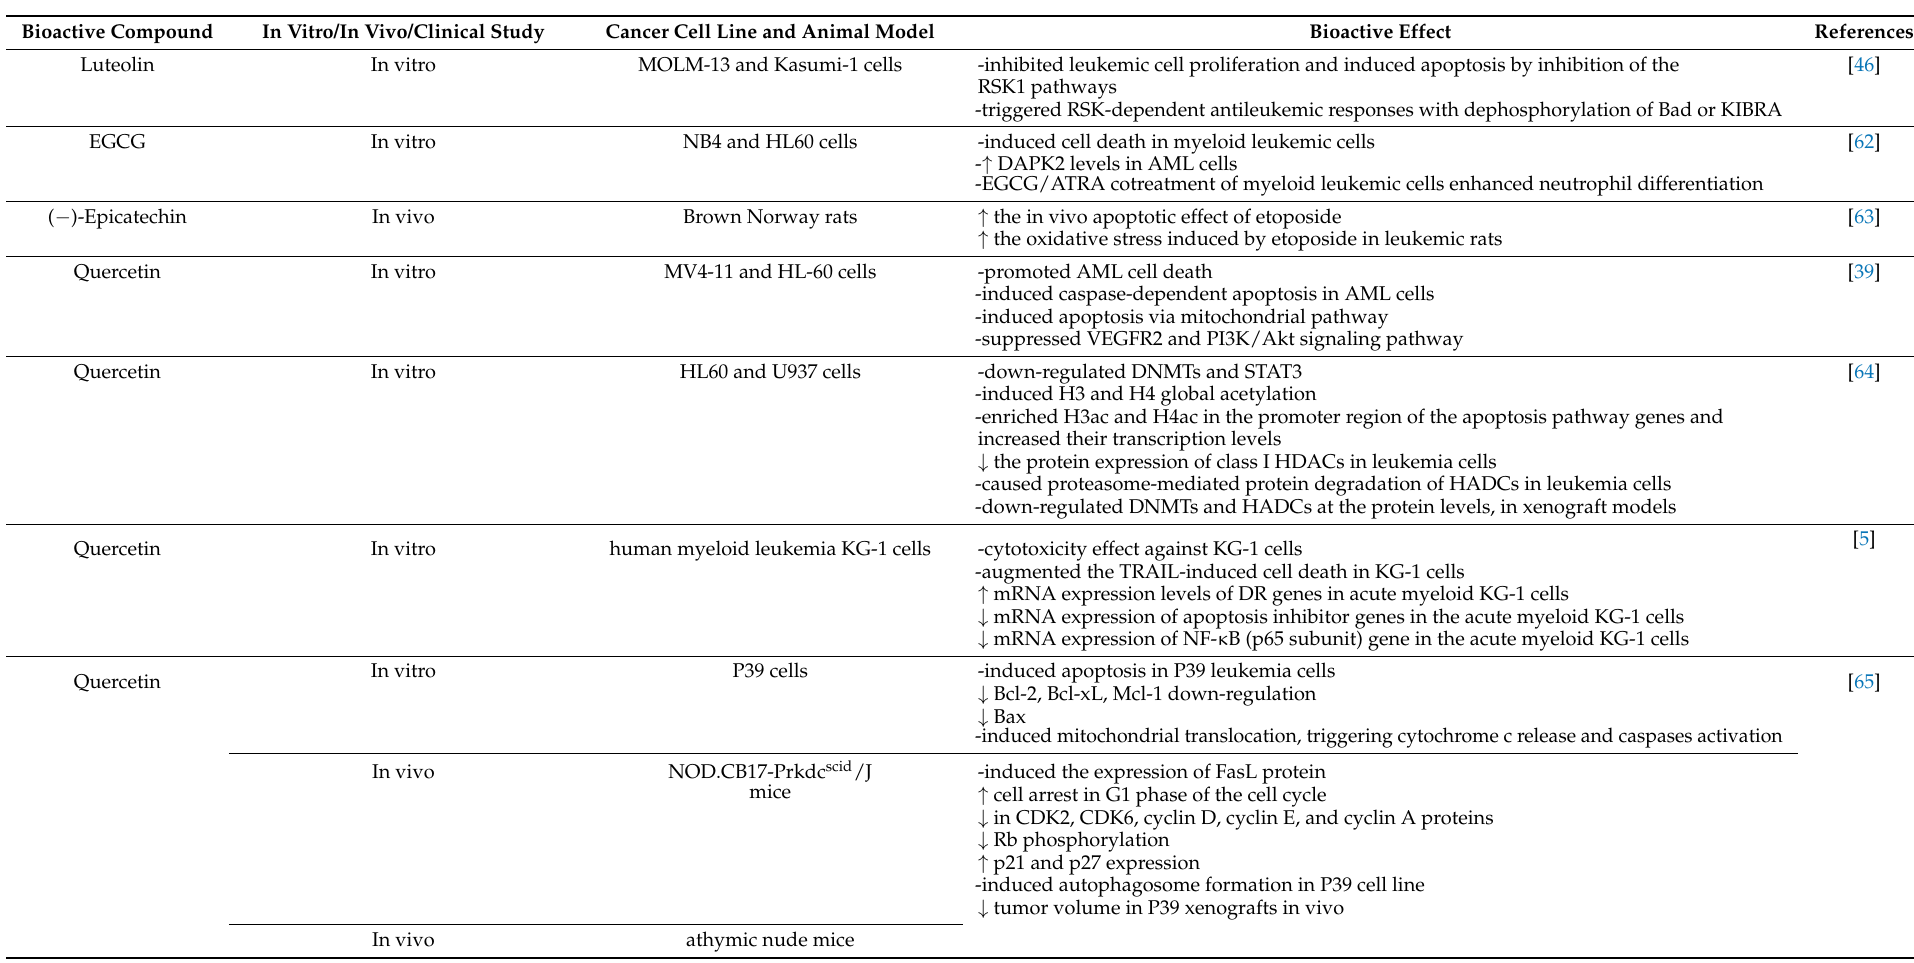
Table 1. Pharmacological effects of natural compounds in acute myeloid leukemia